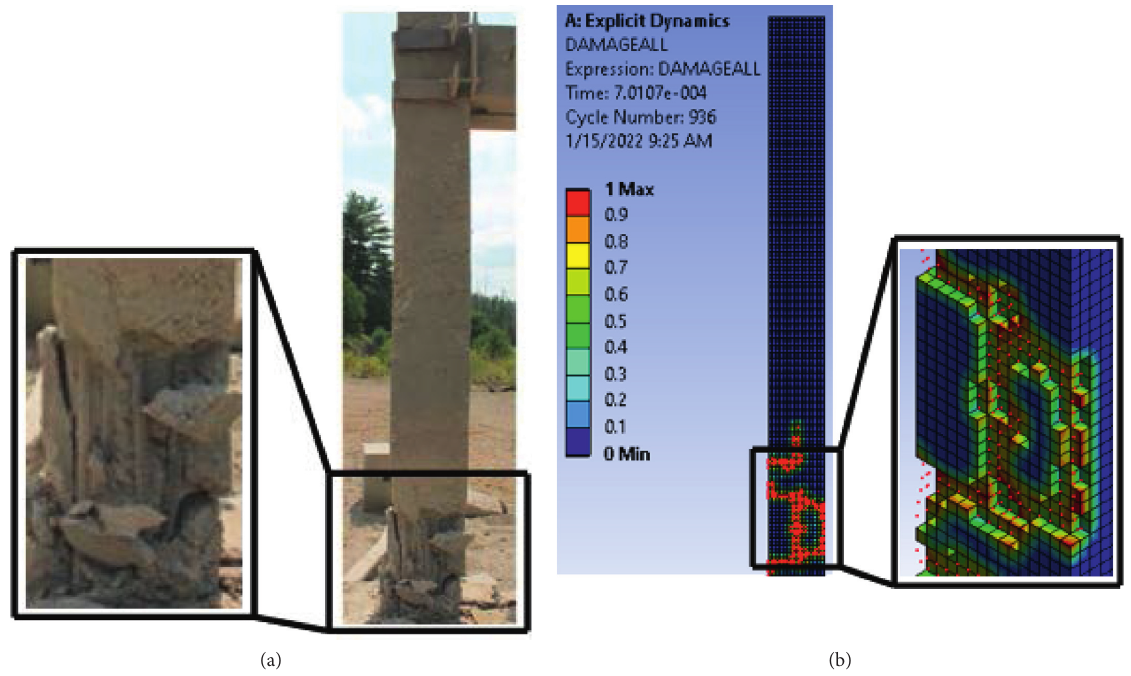
Figure 8: Posttest photograph of column: (a) field test carried out by Siba [20] and (b) FE validation